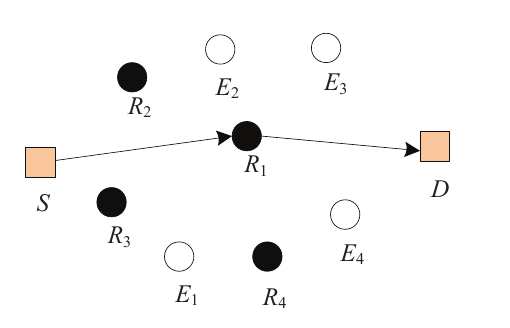
Figure 1. System scenario: Source S wishes to communicate securely with destination D with the assistance of finite relays R 1 , R 2 , (cid:1) (cid:1) (cid:1) , R n ( n =4 in the figure) in the presence of passive eavesdroppers E , E , (cid:1) (cid:1) (cid:1) , E ( m =4 in the figure). Cooperative 1 2 m relay scheme is used in the two-hop transmission. A assistant node is selected randomly as relay ( R in the 1